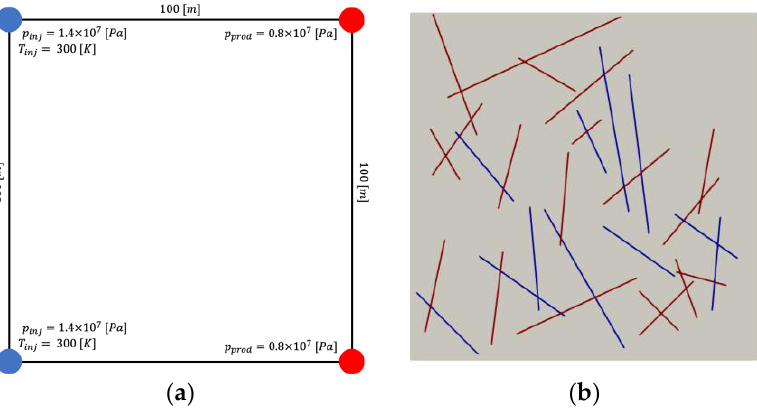
Figure 4. Schematic of the ( a ) production strategy and ( b ) fracture geometry applied in the single- phase test case. The highly conductive fractures are shown in red color and the impermeable ones are colored in blue. Table 1. Input parameters used in the single-phase flow test